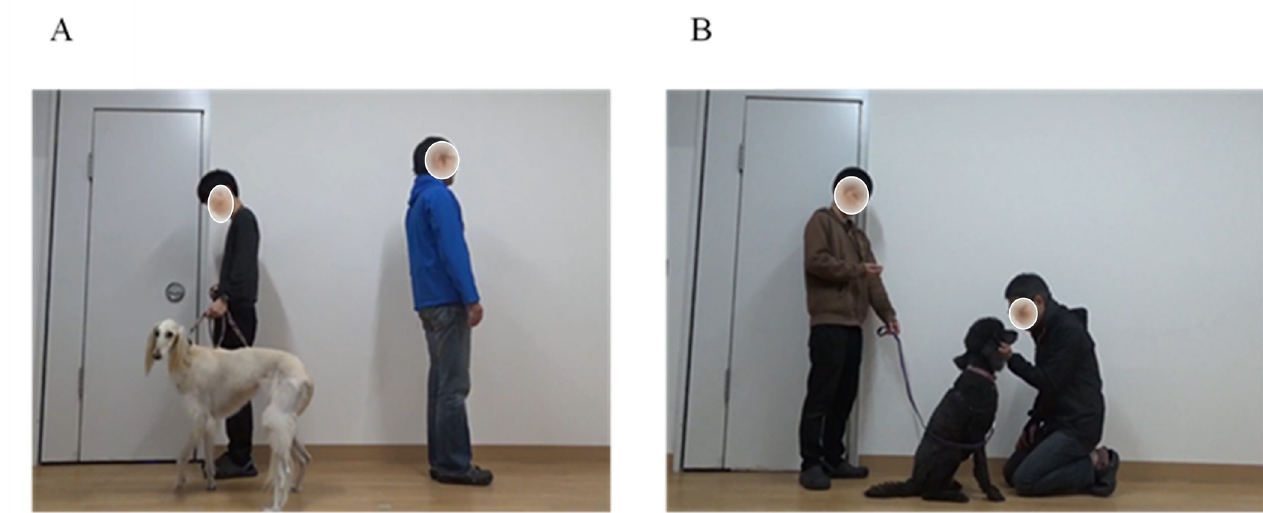
Fig 2. A. A scene from the OW-A-IGN. Enter and exit through the door on the left. The person on the left is the experimenter and retained the dog. The person on the right is the owner of the subject. In this case, the dog is not the owner’s dog. B. A scene from the OW-A-INT, NOW-A-INT, OW-S-IN. Enter and exit through the door on the left. The person on the left is the experimenter. The person on the right is the owner or non-owner. In this case, the dog was either the dog subject or another